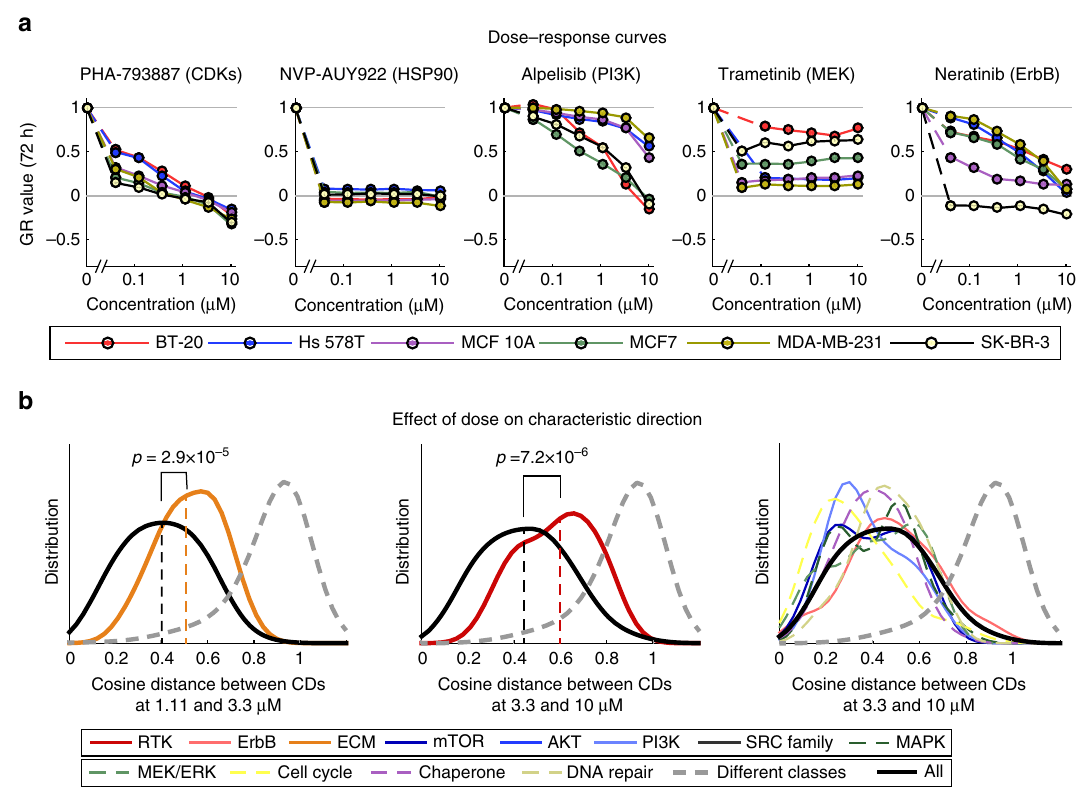
Fig. 2 Variation of molecular and phenotypic responses by cell line and concentration. a Dose – response curves across six cell lines for a subset of drugs that exhibit signi fi cant responses at the level of L1000 signature and phenotype. A GR value of one represents growth at the same rate as the untreated control, a value of zero denotes a complete cytostatic response, and a negative value denotes a cytotoxic response. b Differences in characteristic directions with increase in drug dose as scored by the cosine distance between the characteristic directions of L1000 signatures. Data for ECM inhibitors between 1.11 and 3.33 µ M are shown in yellow (left panel) and receptor tyrosine kinase inhibitors between 3.33 and 10 µ M are shown in red (middle panel). For comparison, the data for all other inhibitor classes between 3.33 and 10 µ M are shown (right panel). Each curve is a smooth density plot by class of drug target. Each distribution is based on an average of 44, but at least 20, different conditions that generally comprises all cell lines. The black line in all panels shows the distribution of all perturbations, colored lines show the distribution for each class of drug targets as indicated in the legend, and dashed gray line the distribution for angles between drugs of different